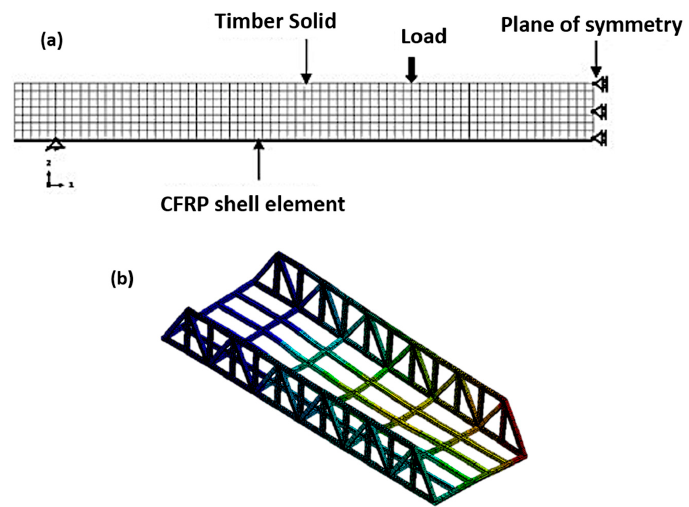
Figure 44. Some applications of FEM for composites in construction: ( a ) Strengthening flexural solid timber beams with CFRP. Reproduced with permission [323] and ( b ) bridges.